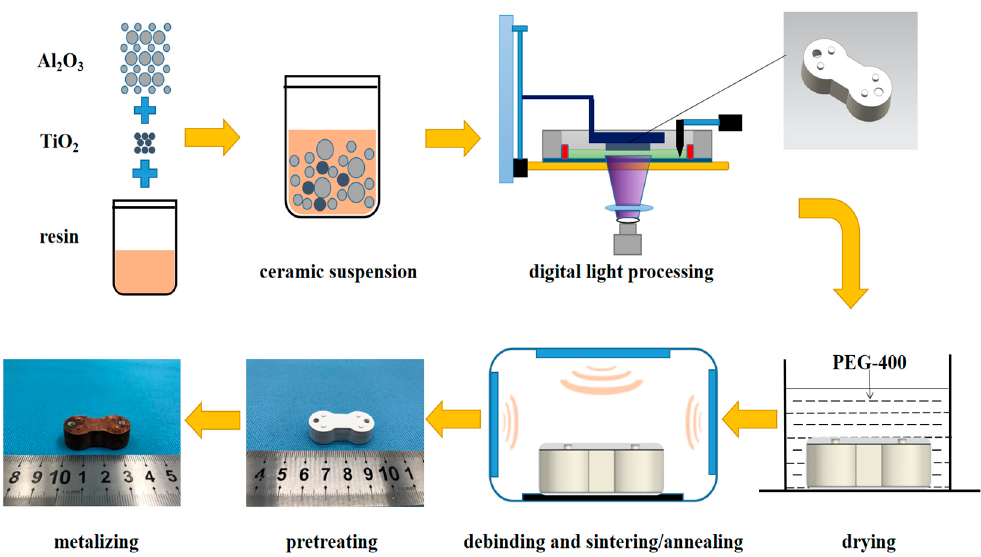
Table 1. Characteristic parameters of the raw material.